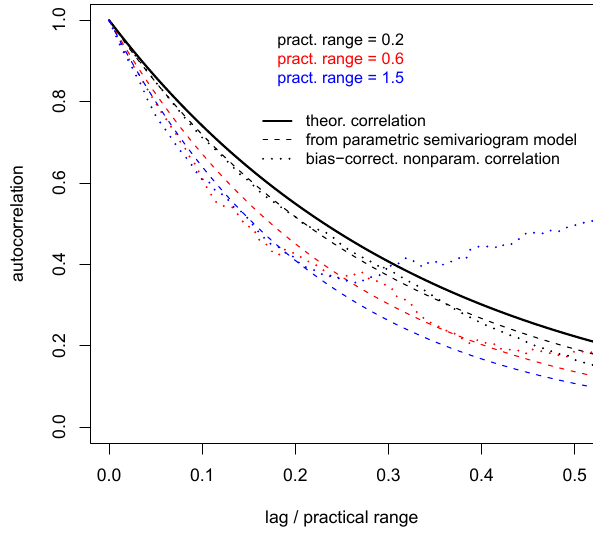
Fig. 4. As Fig. 3 but for bias-corrected nonparametric correlograms calculated according to Eqn. (7). Fig. 3. Behaviour of parametric and nonparametric correlogram estimators for Gaussian spatial processes of different ranges. Dashed black line: Median fitted parametric model for a Gaussian process of practical range 0.2. Dotted black line: Median nonparametric correlogram estimate for a Gaussian process of practical range 0.2. Red and blue lines: the same for processes of larger practical ranges (0.6,1.5). All dashed and dotted lines show the median of estimates of 100 realizations of the Gaussian process. Solid line: theoretical correlation (for all ranges; the abscissa is scaled by the practical range).